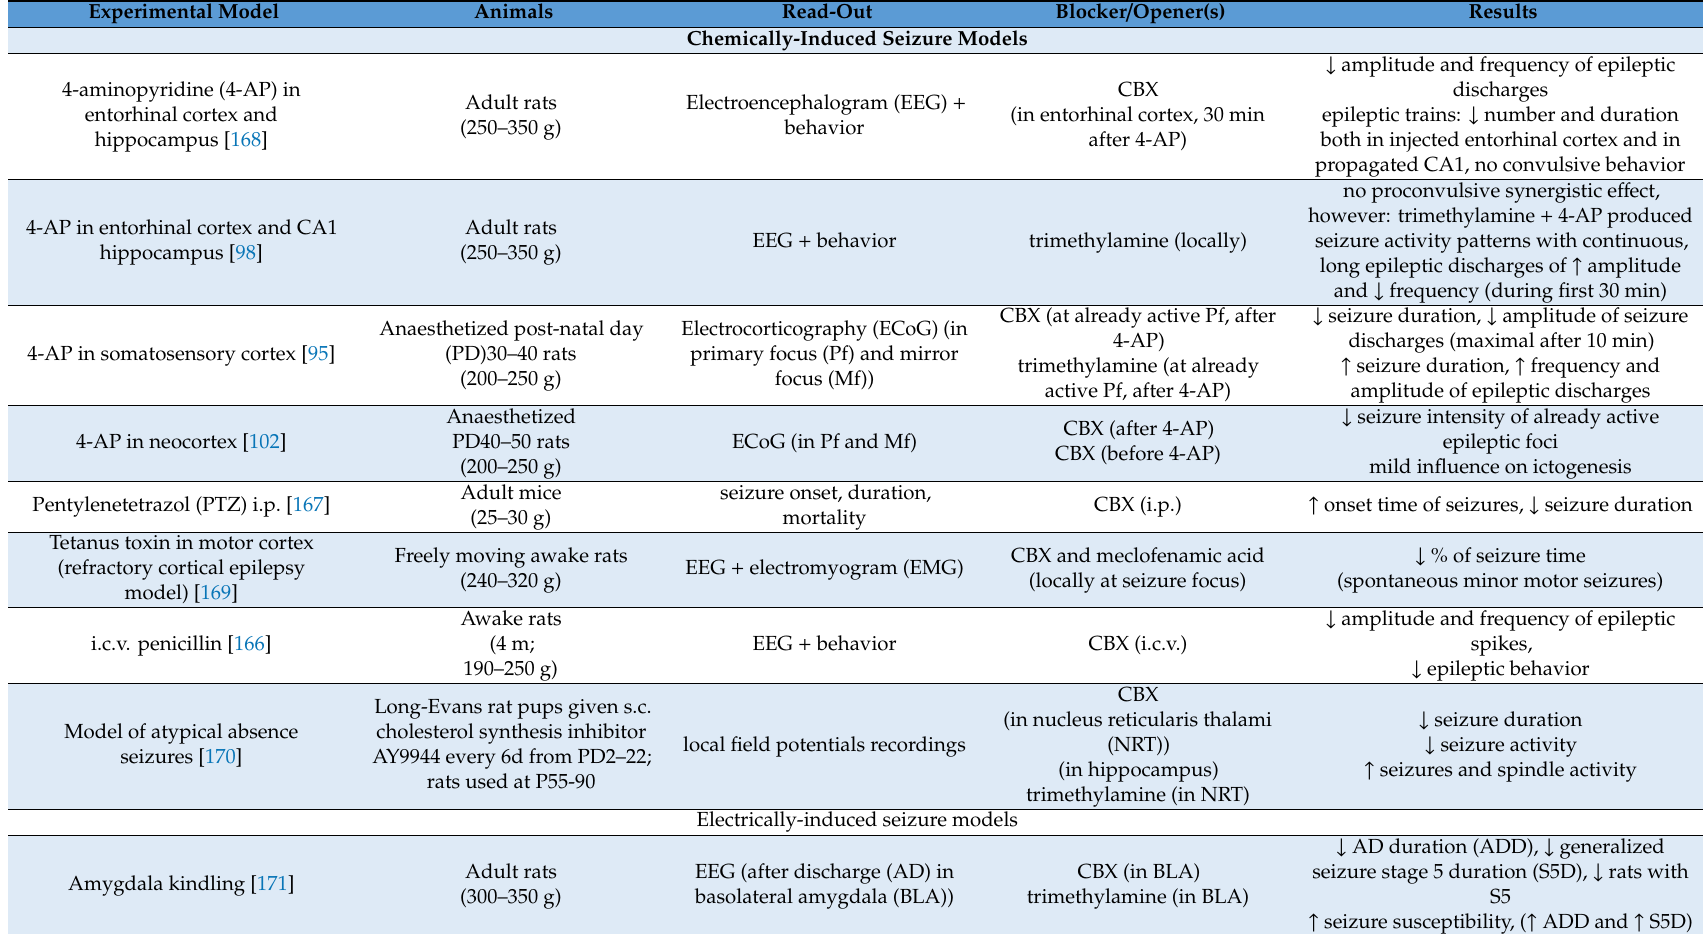
Table 5. E ff ect of non-selective gap junction blockers and openers in in vivo rodent models of seizures and